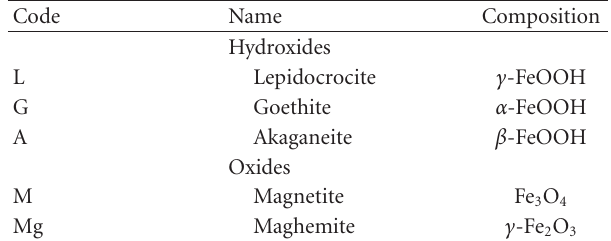
Table 5: Steel corrosion products identified in the MICAT